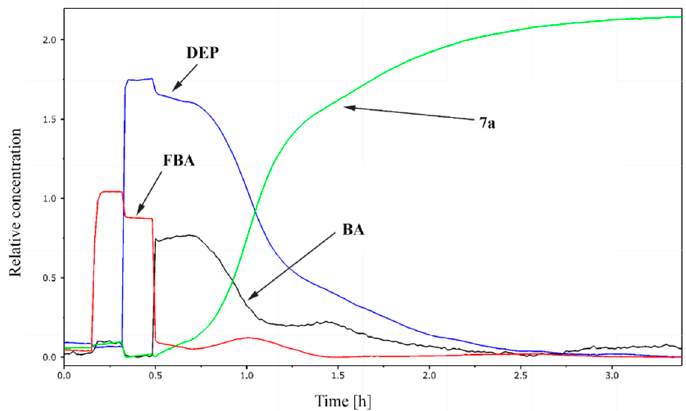
Figure 4. Concentration profiles of the reaction components in the condensation of 2-formylbenzoic acid (FBA ), butylamine ( BA ) and diethyl phosphite ( DEP ) in ethanol.